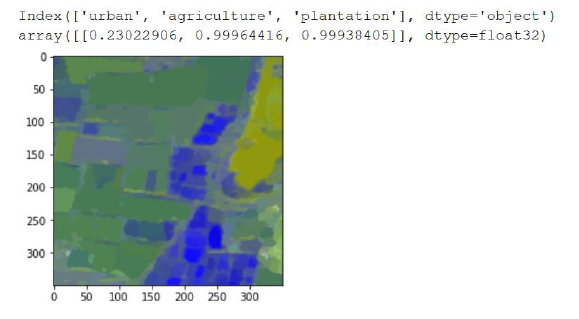
Figure 22 . Result of 350X350 Fused Image.